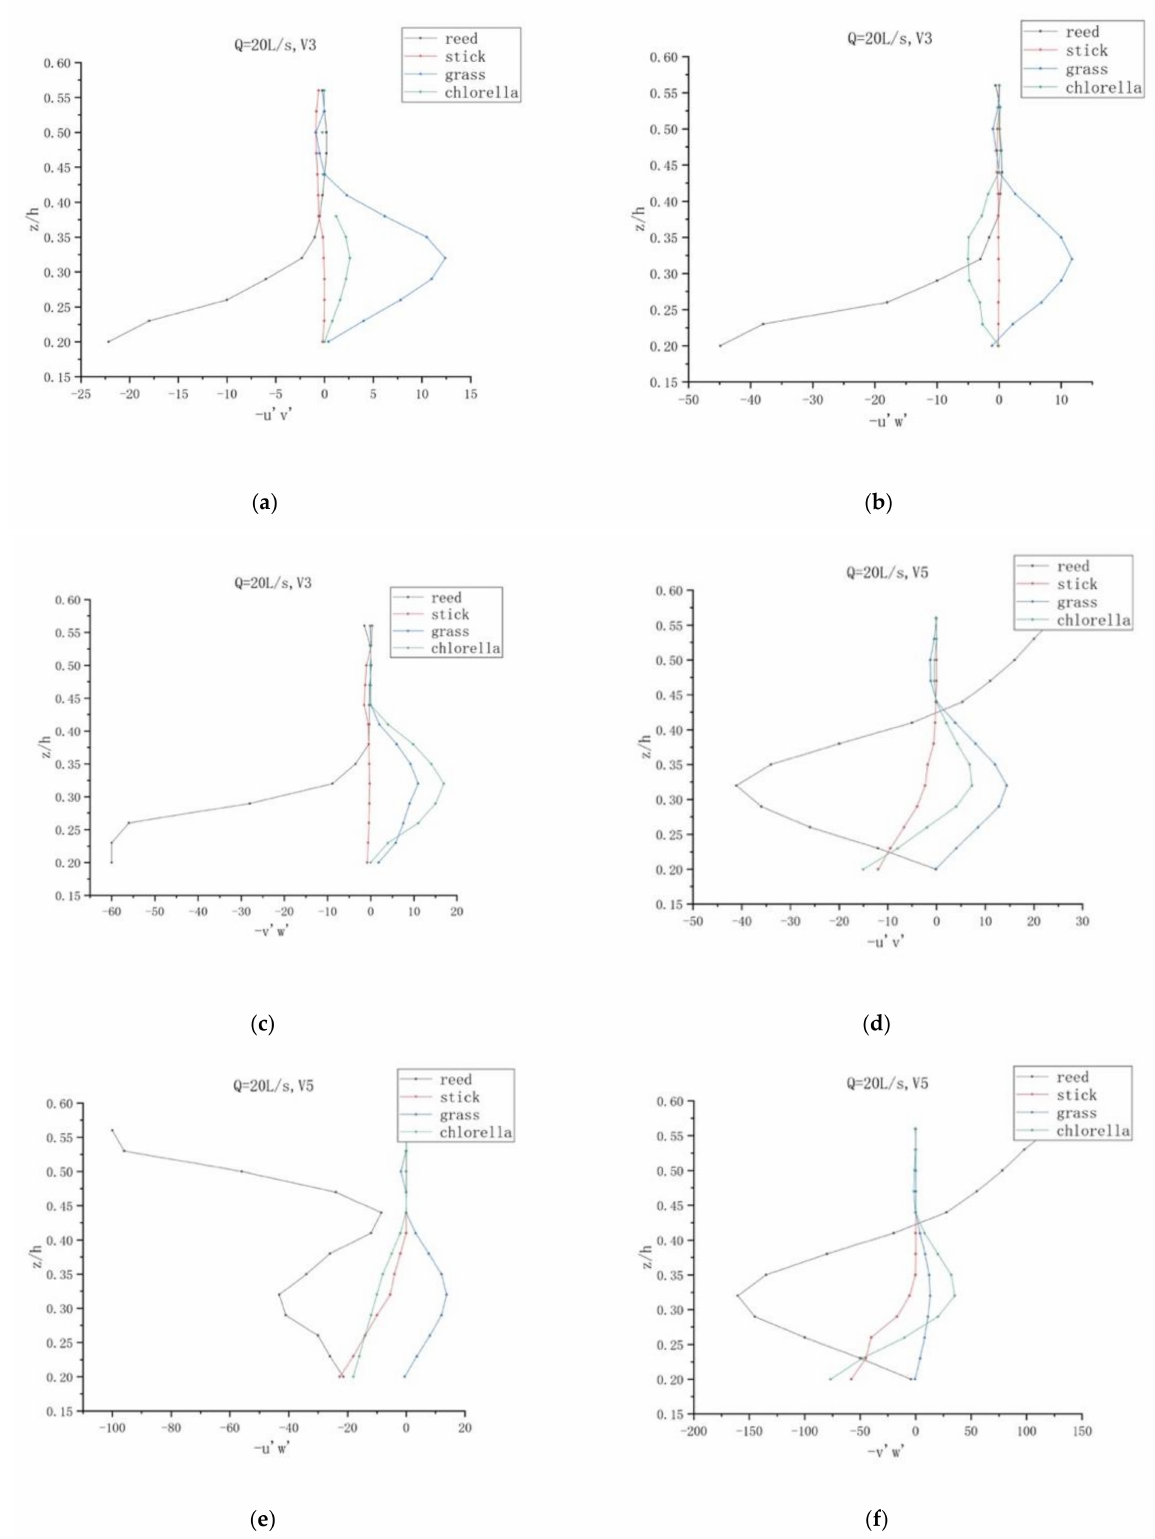
Figure 7. Vertical distributions of − u (cid:48) v (cid:48) , − u (cid:48) w (cid:48) and − v (cid:48) w (cid:48) at verticals 3 and 5, respectively, with Q = 20 L/s for four different vegetations: reed and stick at the length of 30 cm, grass at the length of 10 cm, and the chlorella at the length of 5–6 cm: ( a ) Vertical distributions of − u (cid:48) v (cid:48) at verticals 3 with Q = 20 L/s; ( b ) Vertical distributions of − u (cid:48) w (cid:48) at verticals 3 with Q = 20 L/s; ( c ) Vertical distributions of − v (cid:48) w (cid:48) at verticals 3 with Q = 20 L/s; ( d ) Vertical distributions of − u (cid:48) v (cid:48) at verticals 5 with Q = 20 L/s; ( e ) Vertical distributions of − u (cid:48) w (cid:48) at verticals 5 with Q = 20 L/s; ( f ) Vertical distributions of − v (cid:48) w (cid:48) at verticals 5 with Q = 20